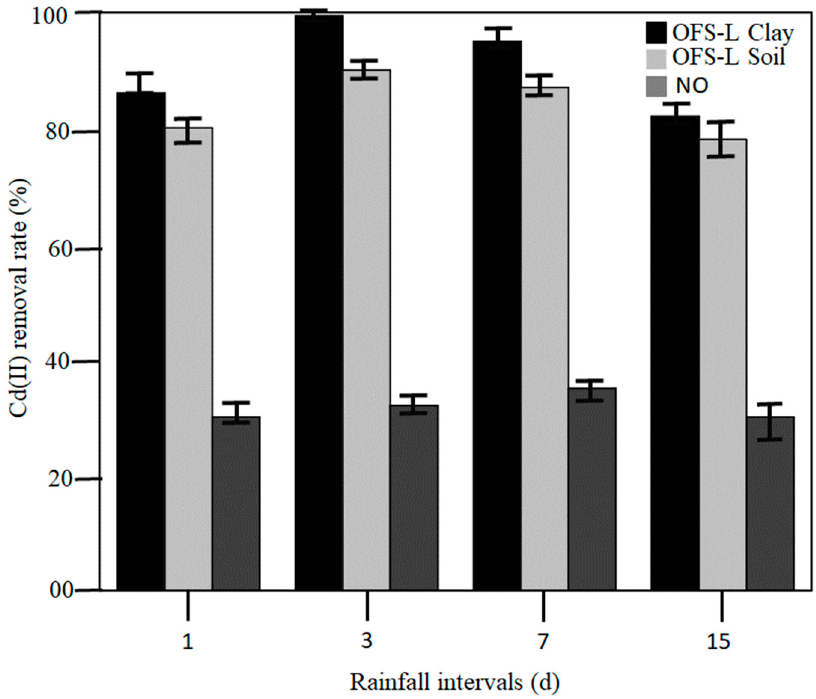
Figure 3. Removal rate of Cd (II) by bioretention system against rainfall intervals (days).